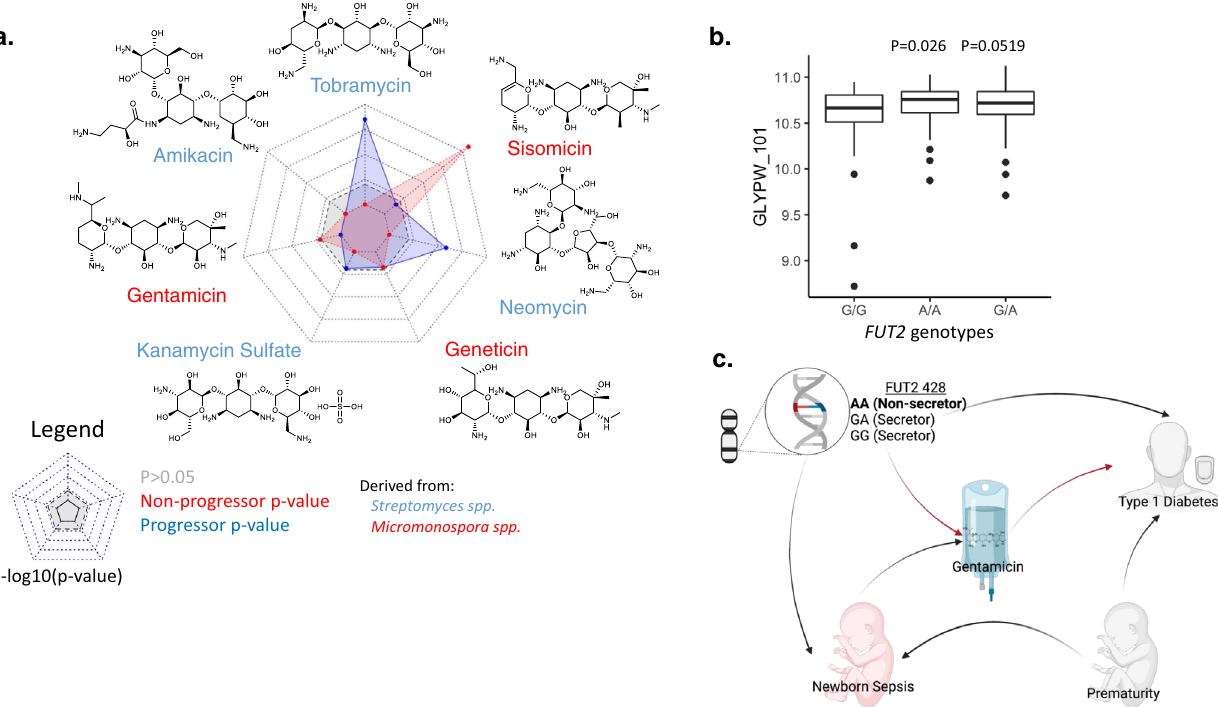
Fig. 4 | ACAs differently detected in non-progressors and progressors com- pared to controls. a Radar charts showing – log10( p value) with blue representing association with progression (blue dots and shaded area) and red representing association with non-progressors (red dots and shaded area). The gray shadowed area represents non-signi fi cances ( p >0.05). Aminoglycoside structures drawn using ChemDraw version 19.1.0.8. b Boxplot of ACA levels against gentamicin for fucosyltransferase-2( FUT2) (rs601338)genotypesG/G( N =41),A/A( N =39),and G/ A ( N =84). Differences between the FUT2 genotype groups were evaluated by Tukey ’ s test accounting for multiple testing with Benjamini-Hochberg method,